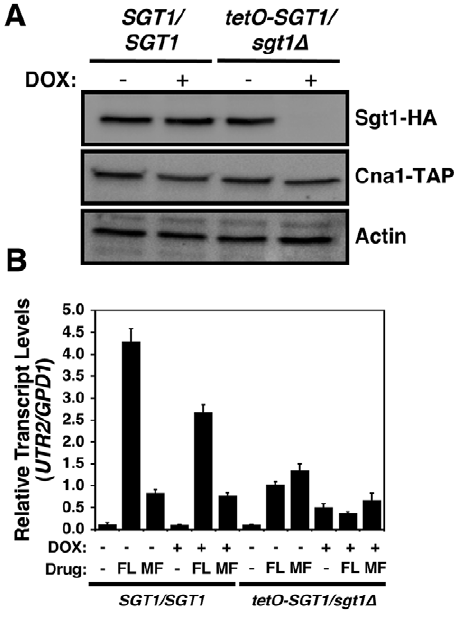
Figure 6. Hsp90 client protein Cna1 retains stability upon depletion of Sgt1, though Sgt1 is required for Cna1 activation. (A) Cna1 retains stability upon depletion of Sgt1. Sgt1 levels were reduced by growth overnight in 20 m g/ml doxycycline, followed by subculture in fresh medium with 20 m g/ml doxycycline and growth until mid-log phase. First panel, immune blot analysis of Sgt1 levels (50 m g protein loaded per well); and second panel, immune blot analysis of Cna1-TAP levels (50 m g protein loaded per well). Actin was used as a loading control. (B) Sgt1 is required for Cna1 activation in response to fluconazole or micafungin. Transcript levels of a Cna1- dependent gene, UTR2 , were measured for the wild-type ( SGT1/SGT1 ) or tetO-SGT1/sgt1 D strains by quantitative RT-PCR after growth in rich medium at 30 u C with or without 20 m g/ml doxycycline (DOX), 16 m g/ml fluconazole (FL), and 30 ng/ml micafungin (MF), as indicated. UTR2 transcript levels were normalized to GPD1 . Data are means 6 standard deviations for triplicate